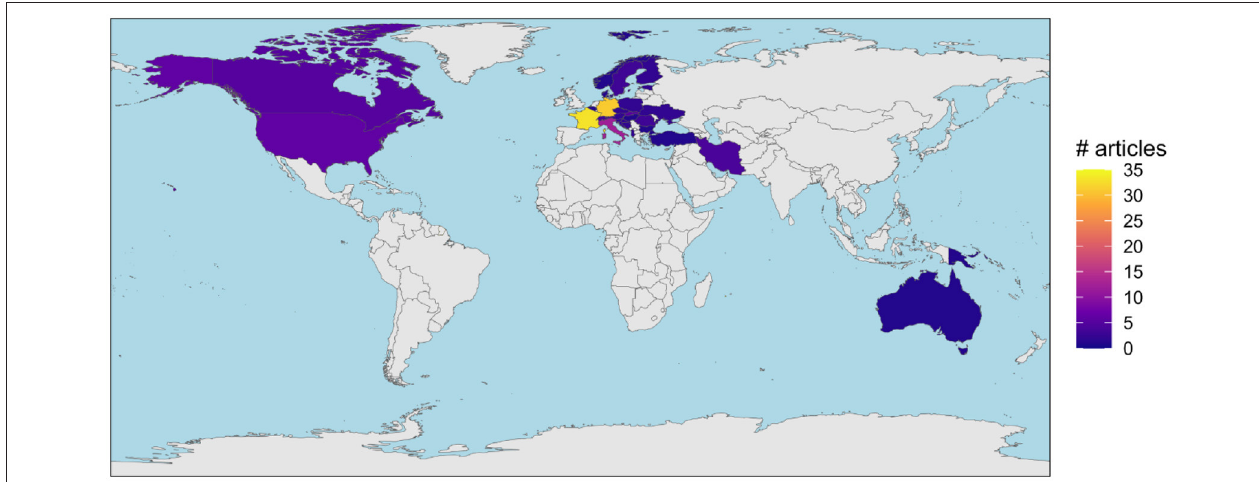
FIGURE 4 | Map of the number of articles from the corpus covering world countries. Gray fill indicates no article identified for the country, blue indicates seas and oceans.